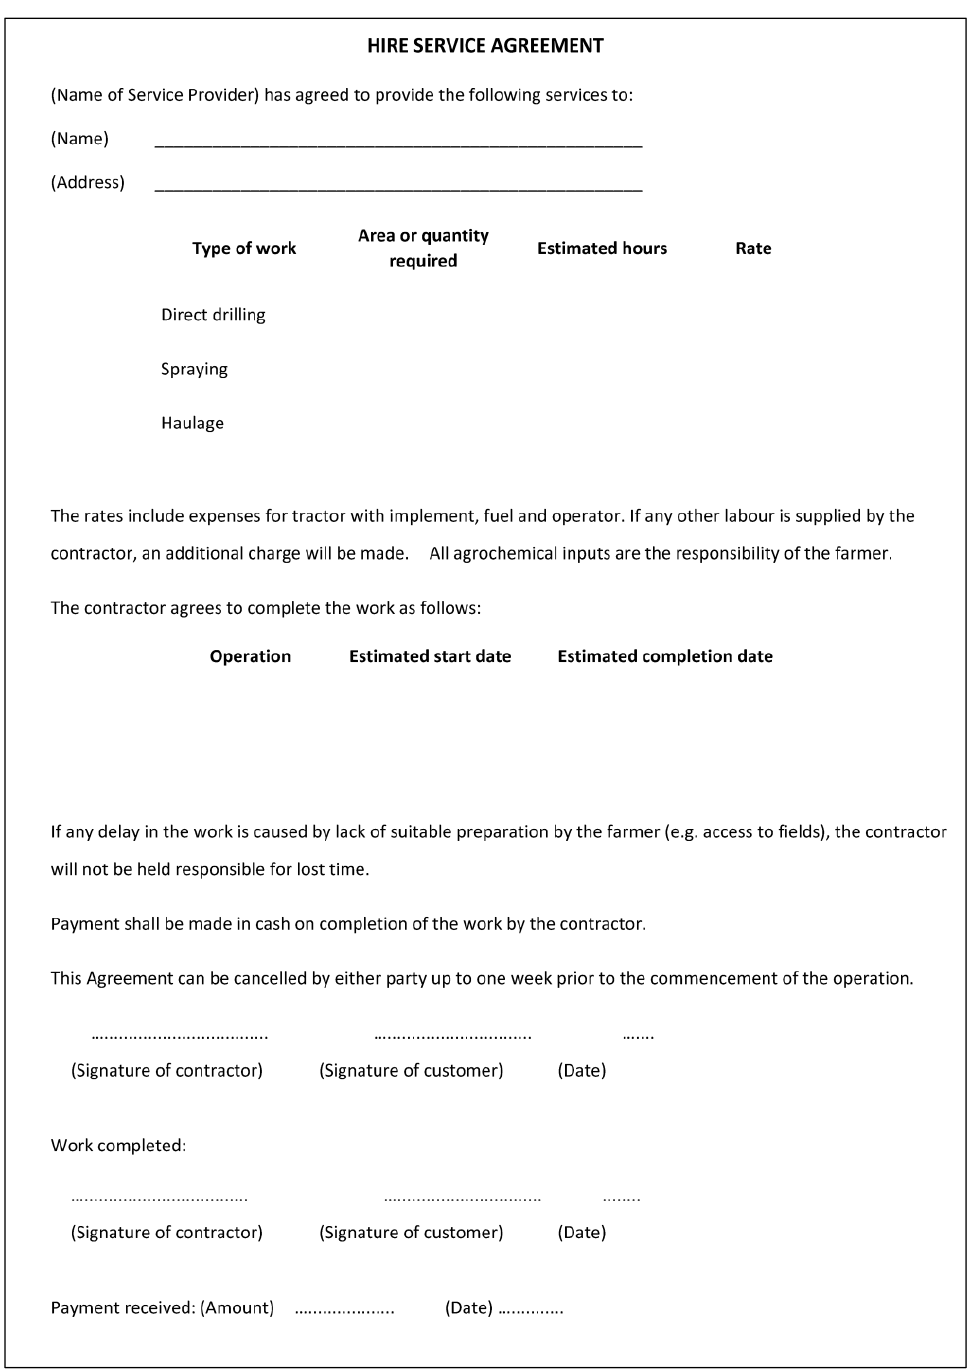
Figure 5. An example of a custom service provision contract between the service provider and the client farmer.